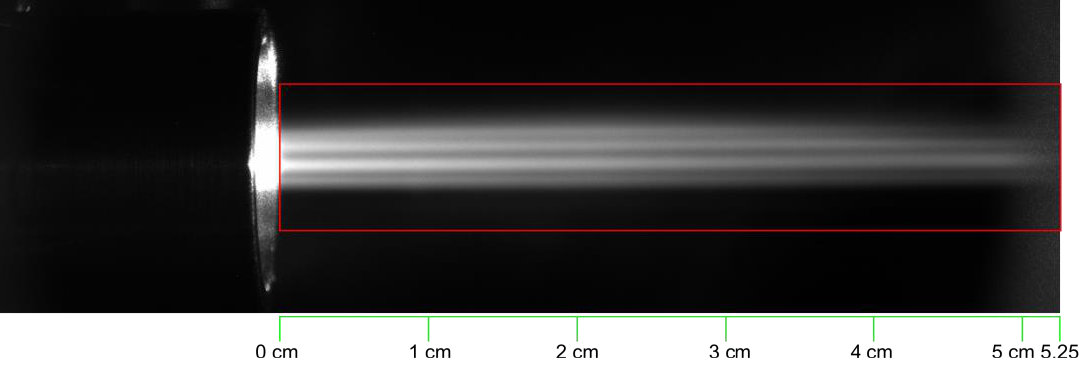
Figure 4. Example picture of the fluorescence acquired with the CMOS camera. Shown is the mid- range nozzle at the centroid frequency of the transition using a stagnation pressure of 100 mbar and a background pressure of 6.47 × 10 −3 mbar. The visible stripes in the jet are a property of the laser diode used. The red box indicates the region that was considered in the analysis.